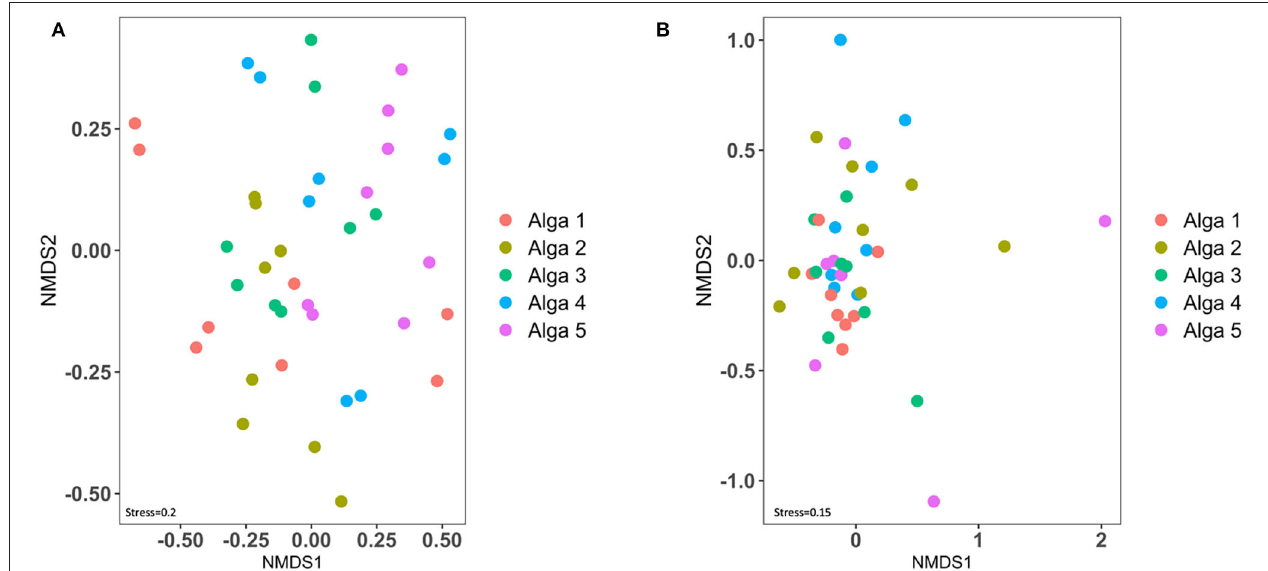
FIGURE 4 | Beta-diversity analysis of bacterial (A) and fungal (B) communities of the Saccharina latissima microbiota.